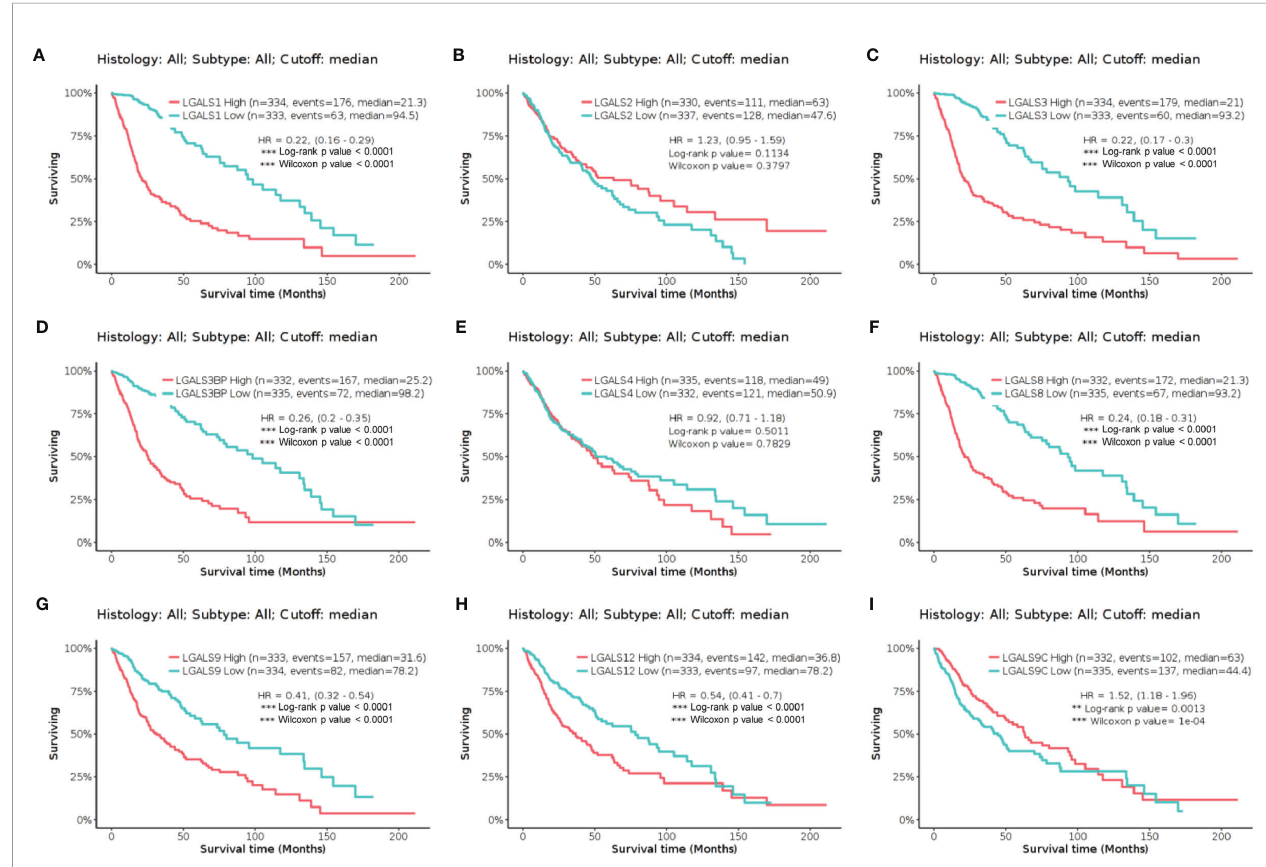
FIGURE 1 | The Kaplan – Meier curve of LGALS genes in TCGA Glioma dataset. (A) The Kaplan – Meier curve of LGALS1 in TCGA Glioma dataset. (B) The Kaplan – Meier curve of LGALS2 in TCGA Glioma dataset. (C) The Kaplan – Meier curve of LGALS3 in TCGA Glioma dataset. (D) The Kaplan – Meier curve of LGALS3BP in TCGA Glioma dataset. (E) The Kaplan – Meier curve of LGALS4 in TCGA Glioma dataset. (F) The Kaplan – Meier curve of LGALS8 in TCGA Glioma dataset. (G) The Kaplan – Meier curve of LGALS9 in TCGA Glioma dataset. (H) The Kaplan – Meier curve of LGALS12 in TCGA Glioma dataset. (I) The Kaplan – Meier curve of LGALS9C in TCGA Glioma dataset. TCGA, The Cancer Genome Atlas **p<0.01,